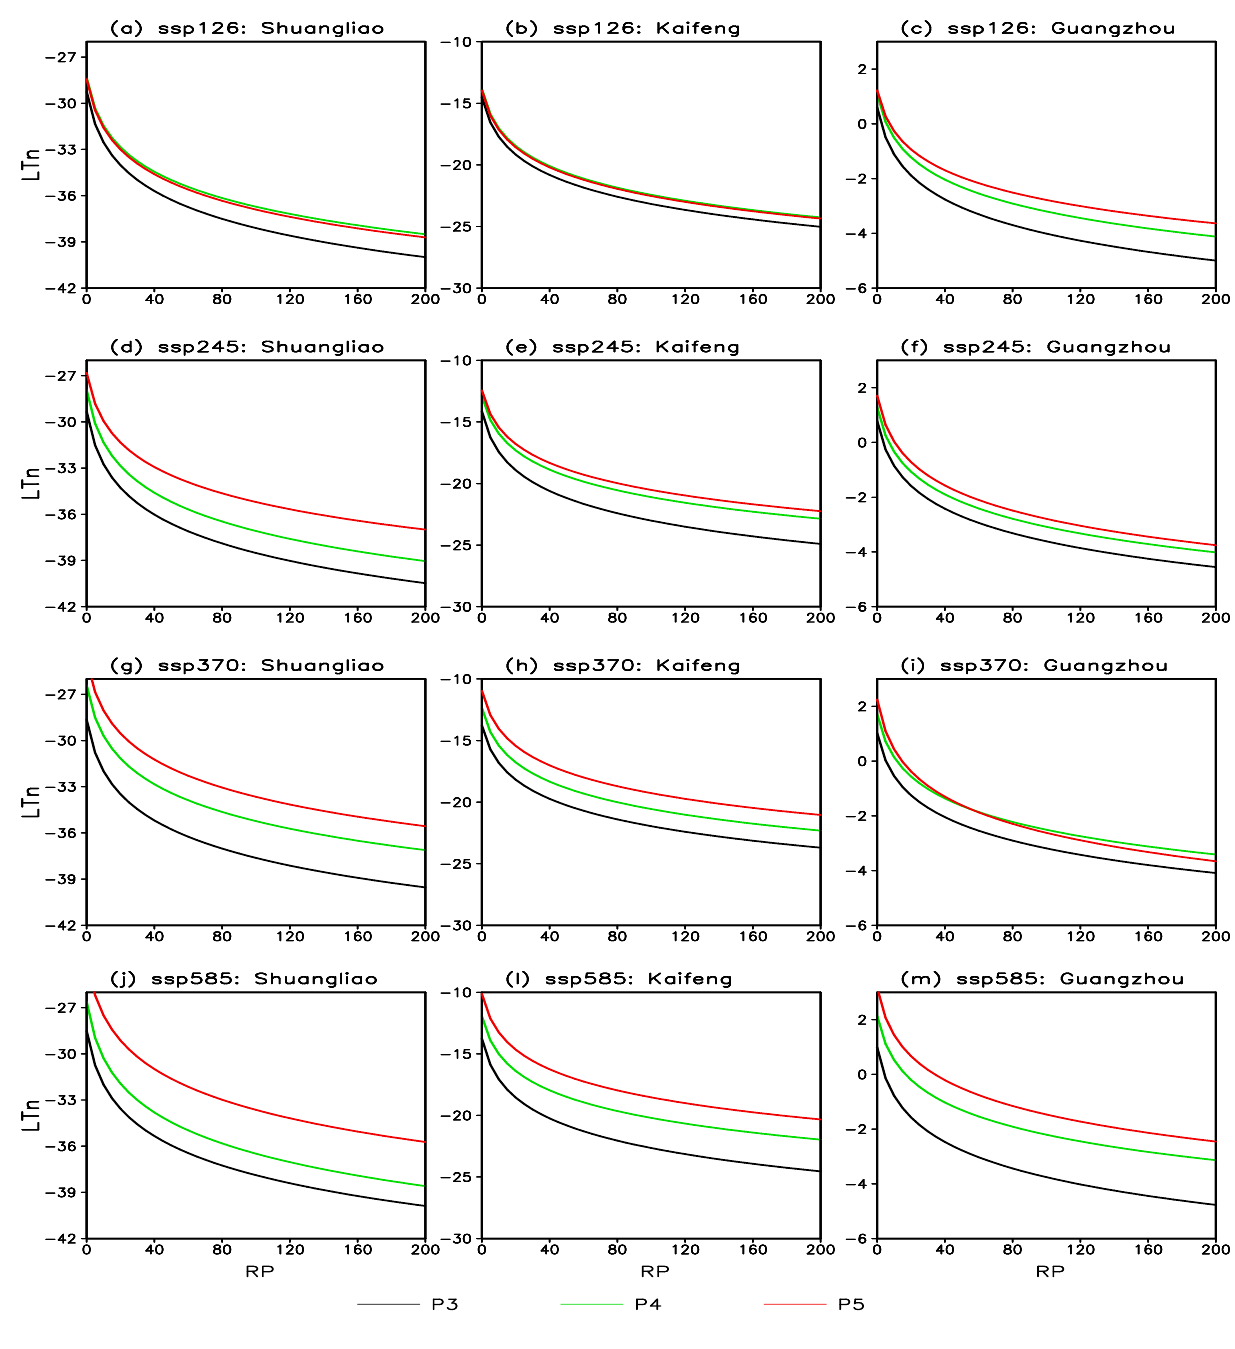
Fig. 8 Same as Fig. 6 but for